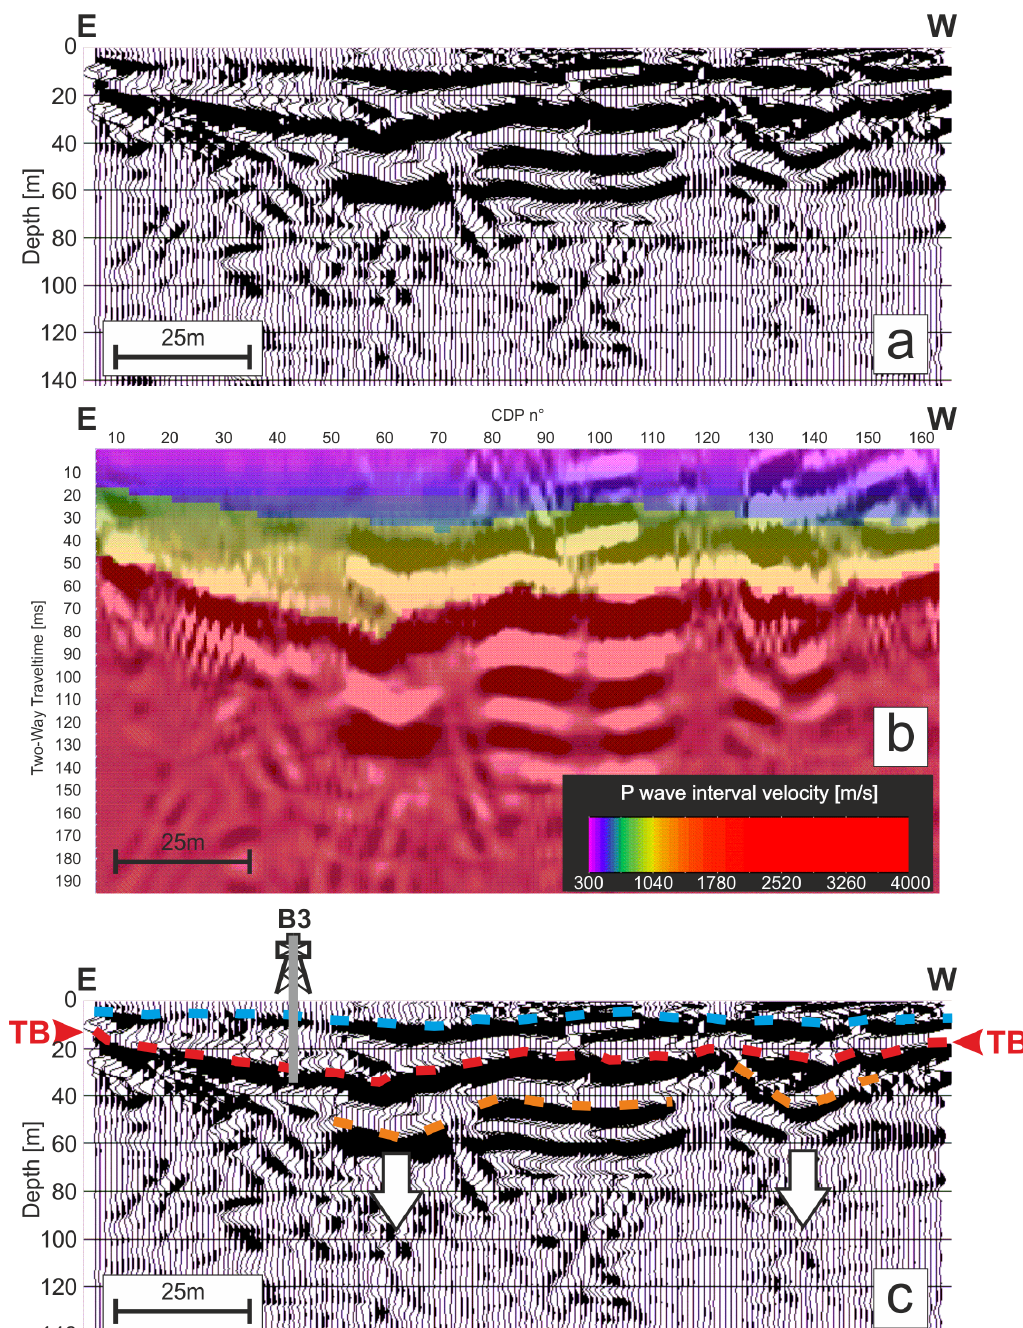
Figure 7. Reflection seismic profile PS1. ( a ) Processed depth converted profile; ( b ) Two-way traveltime (TWT) profile with the interval velocity superimposed; ( c ) interpreted depth converted profile. The red dashed line marks the top of the bedrock (TB), while light blue and orange lines highlight seismic horizons within the sediments and within the evaporites, respectively. The location and depth of borehole B3 used for validation are also provided.